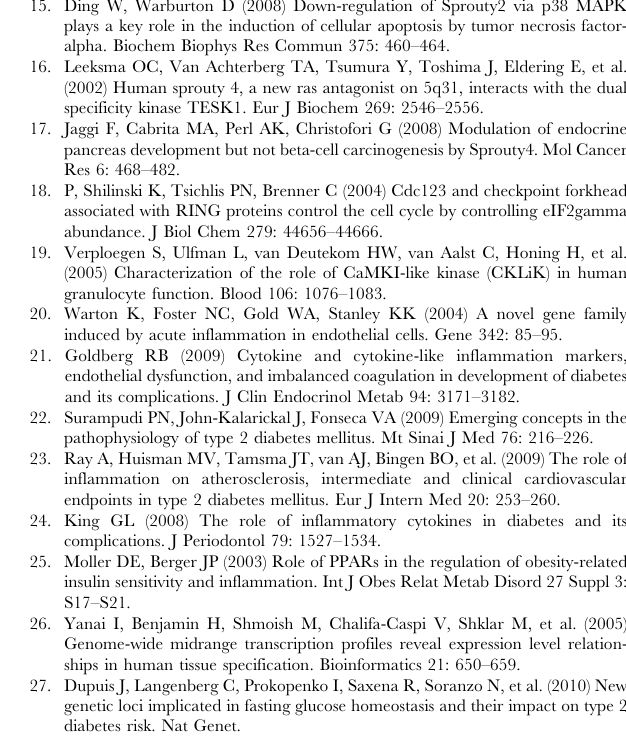
Table S3 Association of SNPs that are in LD with established SNPs in European-ancestry populations (for SNPs discovered in European ancestry populations) or with the reported SNPs in Asians (for SNPs discovered in Asians).